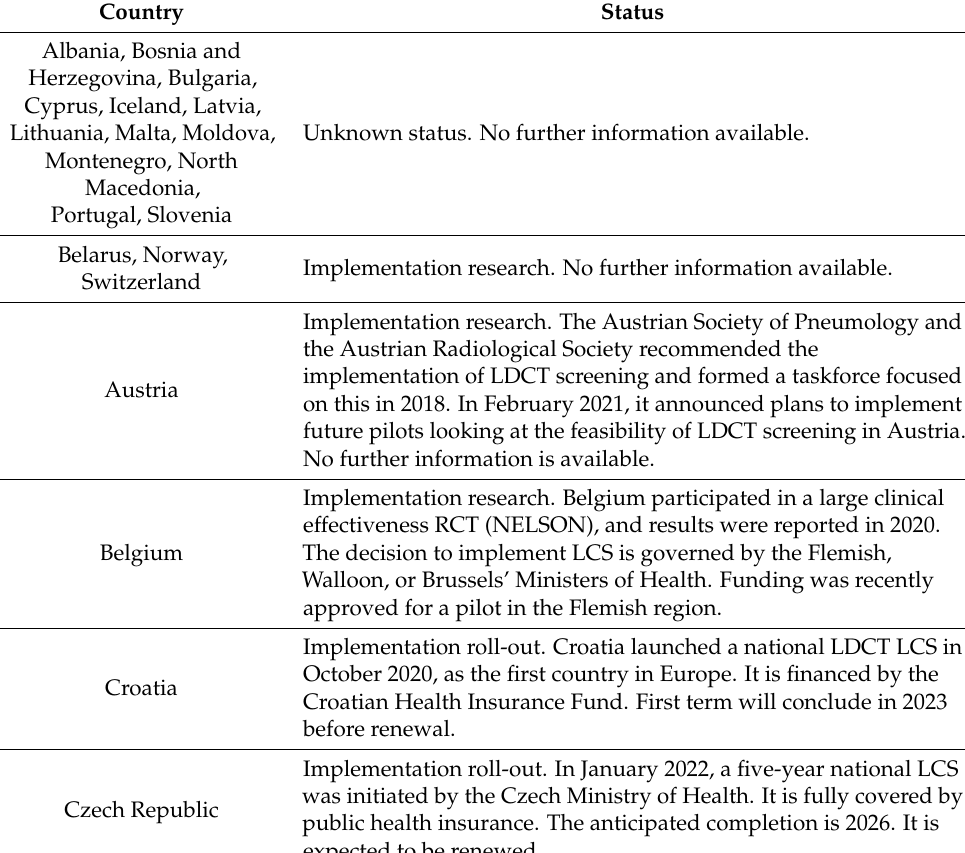
Table 1. Lung cancer screening in European countries according to the first edition of the Interactive Map of Lung Cancer Screening. According to the data collected by The Lung Cancer Policy Network (LCPN) 2022. Status from the LCPN data